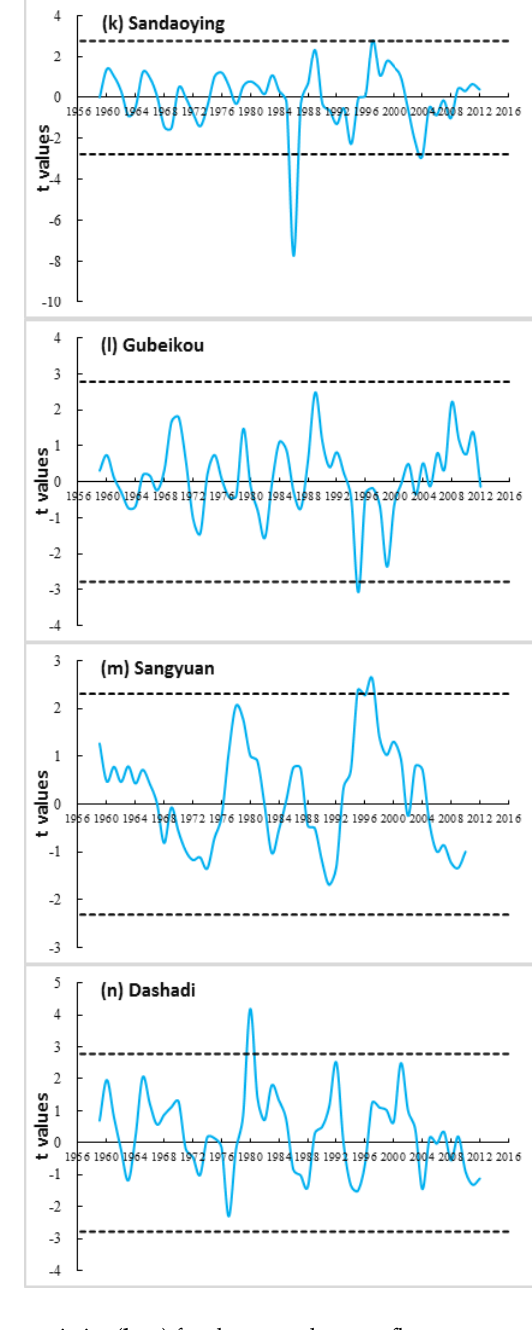
Figure 2. Mann-Kendall test statistics ( a – g ) and t -test statistics ( h – n ) for the annual streamflow over the period 1956–2016. The horizontal dashed lines show the critical value ( p < 0.05).